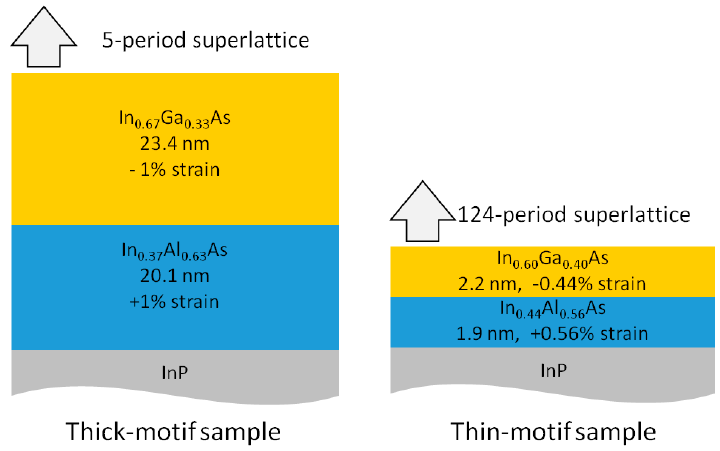
Figure 1. Schematic diagrams of the motif characteristics of the superlattice samples.